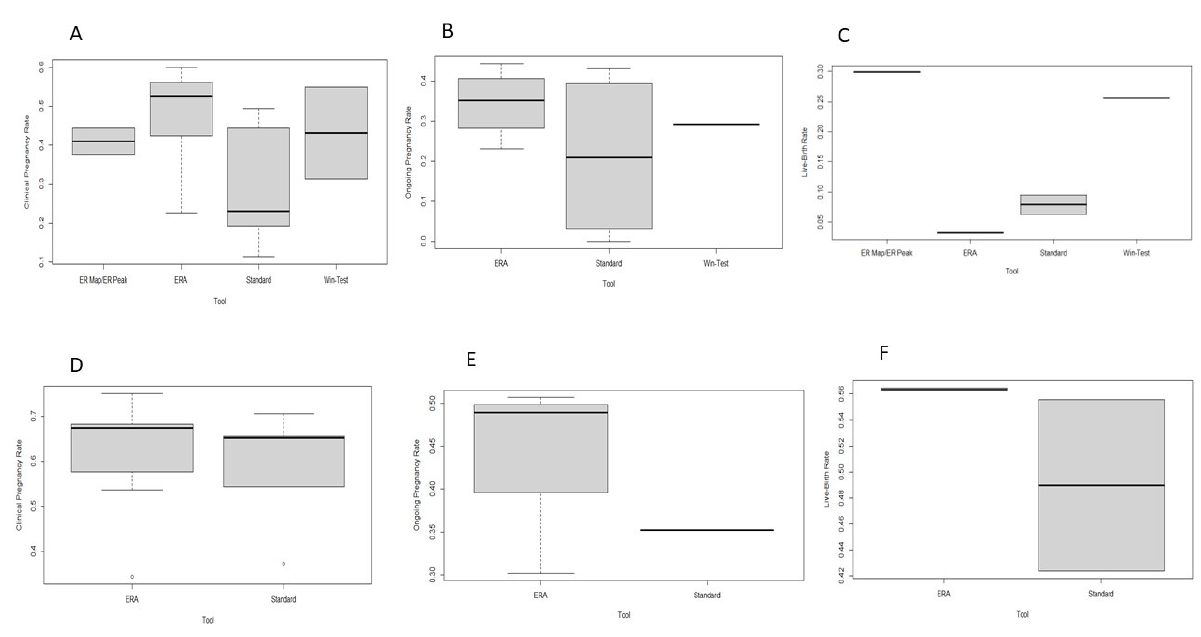
Figure 2. Boxplot of the clinical outcomes. ( A ): Clinical Pregnancy rates in RIF patients; ( B ): Ongoing Pregnancy rates in RIF patients; ( C ): Live-birth rates in RIF patients; ( D ): Clinical Pregnancy rates in non-RIF patients; ( E ): Ongoing Pregnancy rates in non-RIF patients; ( F ): Live-birth rates in non-RIF patients .